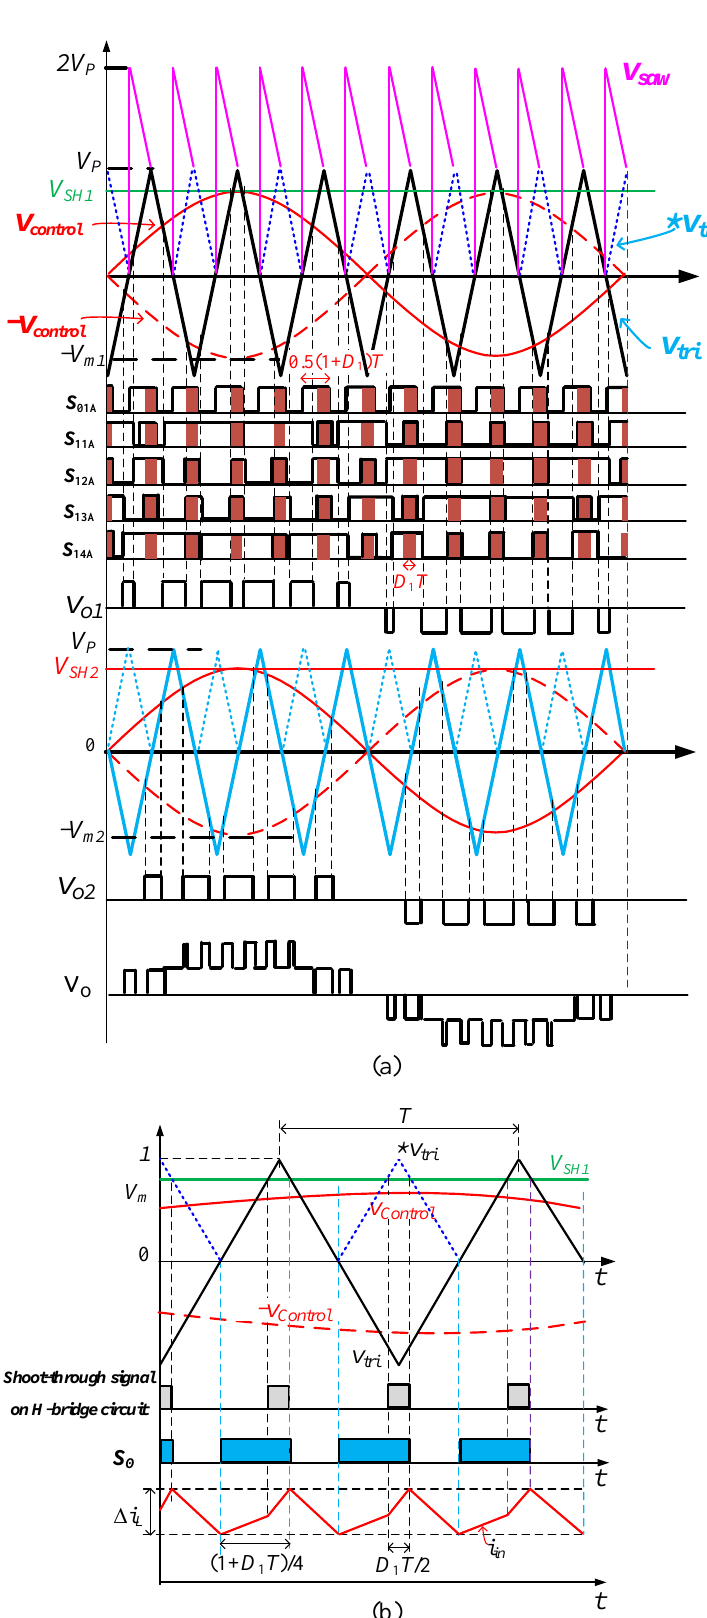
Figure 5. Improved PWM strategy for three-phase CHB-qSBI. ( a ) Improved PWM strategy for phase-A of the CHB-qSBI and ( b ) ST on H-bridge and S 0 signal